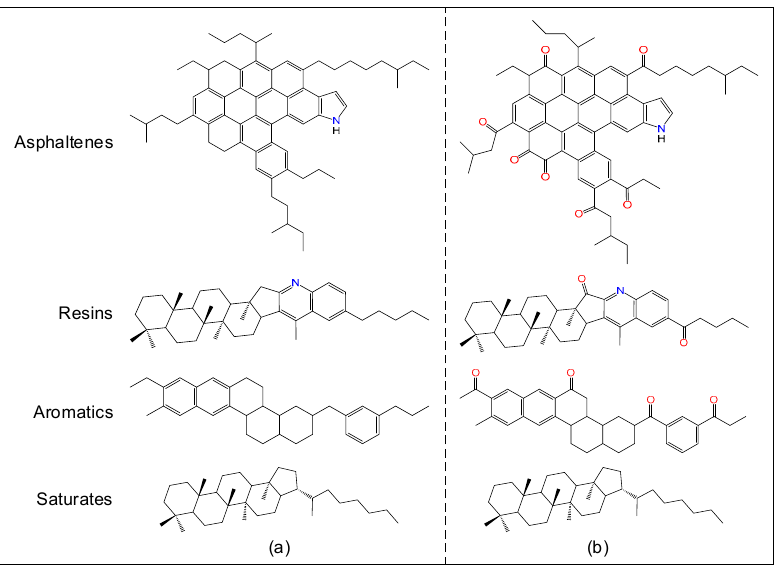
Figure 1. Molecular structures representing the four fractions of the ( a ) virgin and ( b ) aged asphalts. Table 1. Compositions of the virgin and aged asphalt models.